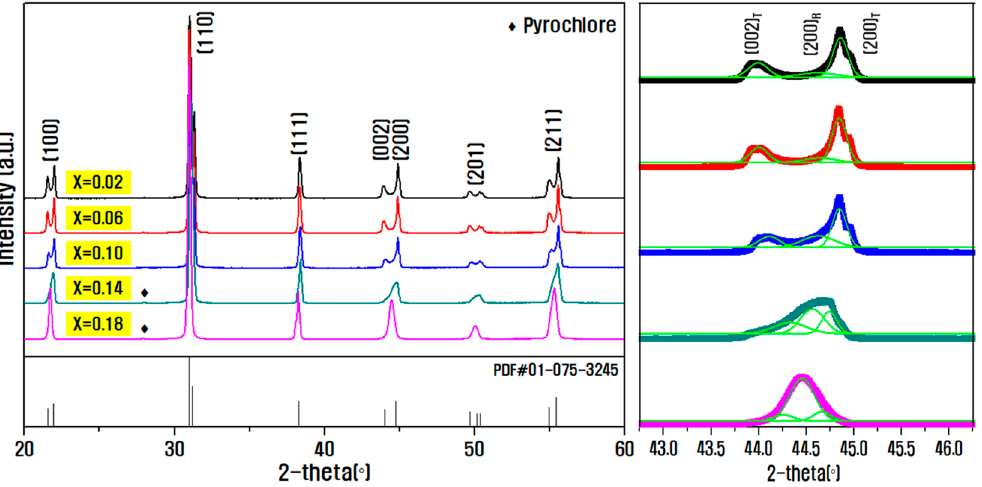
Figure 2. X-ray diffraction pattern analysis results according to PMN content in the (0.20 −